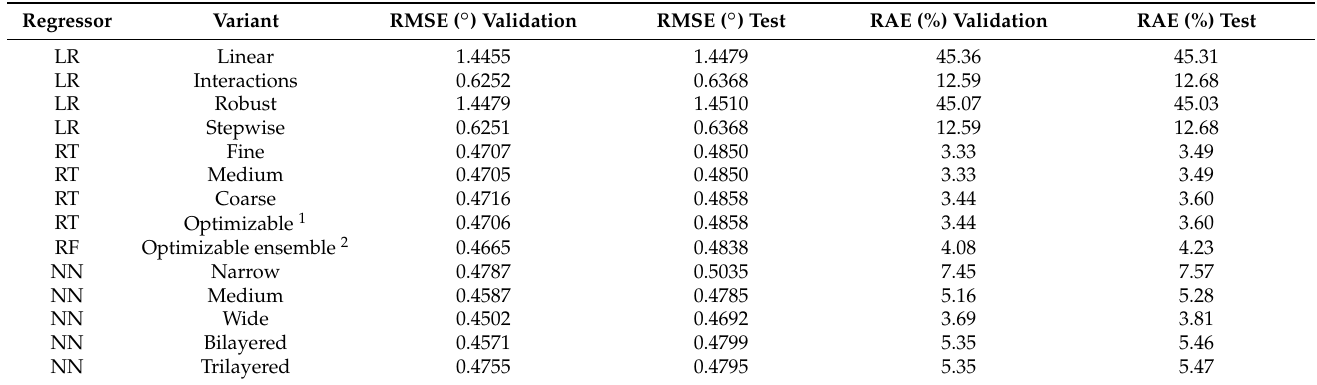
Table 2. Results of training the regressors considering (cid:101) normal and the rotation axis between normals with holdout